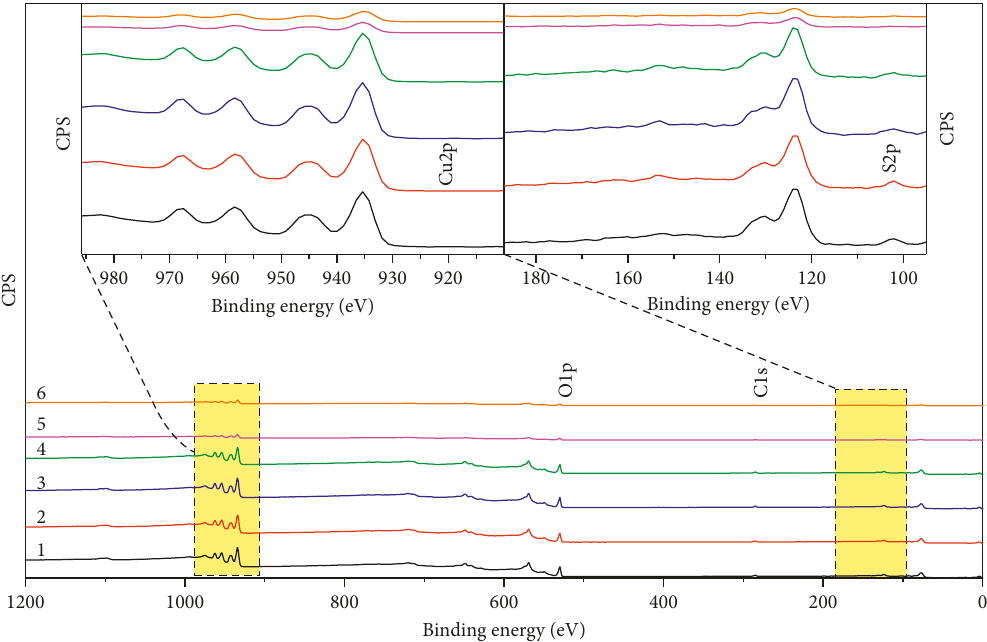
Figure 8: Comparison of CuO adsorption with and without different